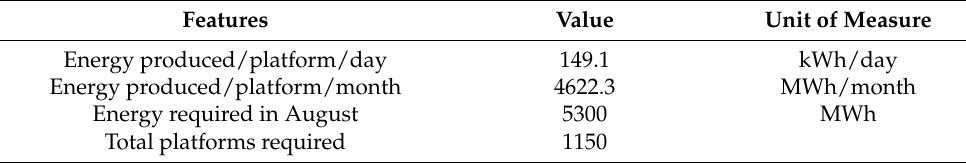
Table 9. Estimation of the number of platforms required based on the data for August. Features Value Energy produced/platform/day